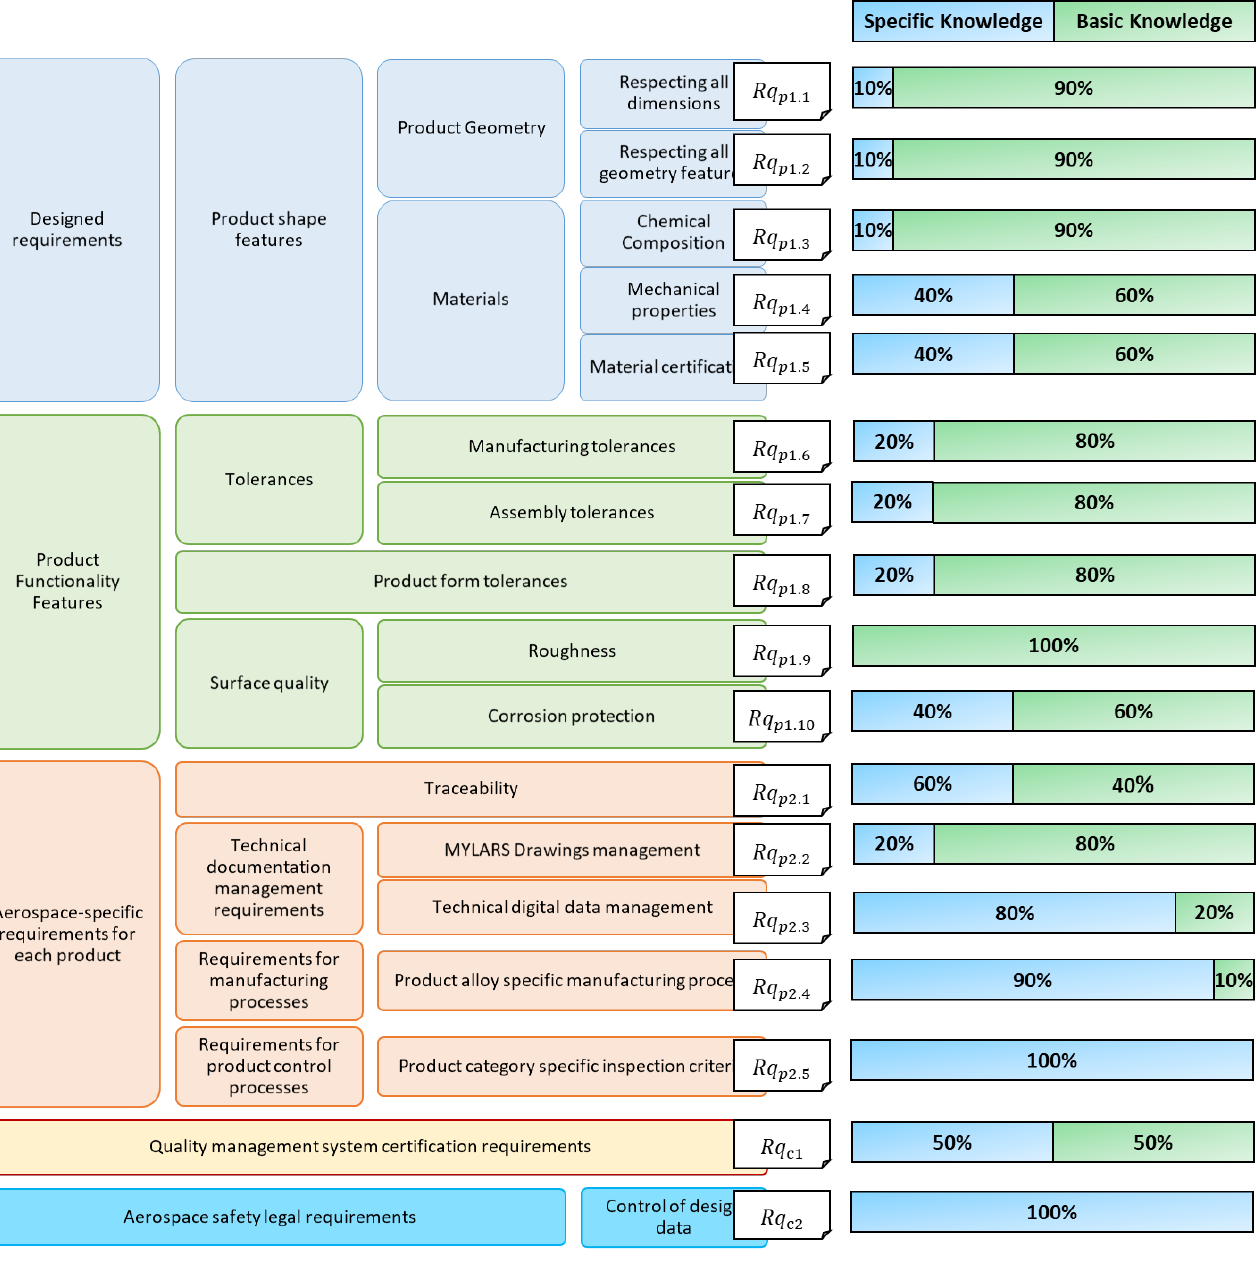
Figure 13. Estimation of the proportions of knowledge in the global engineering process on the quality requirements of structural metal products.